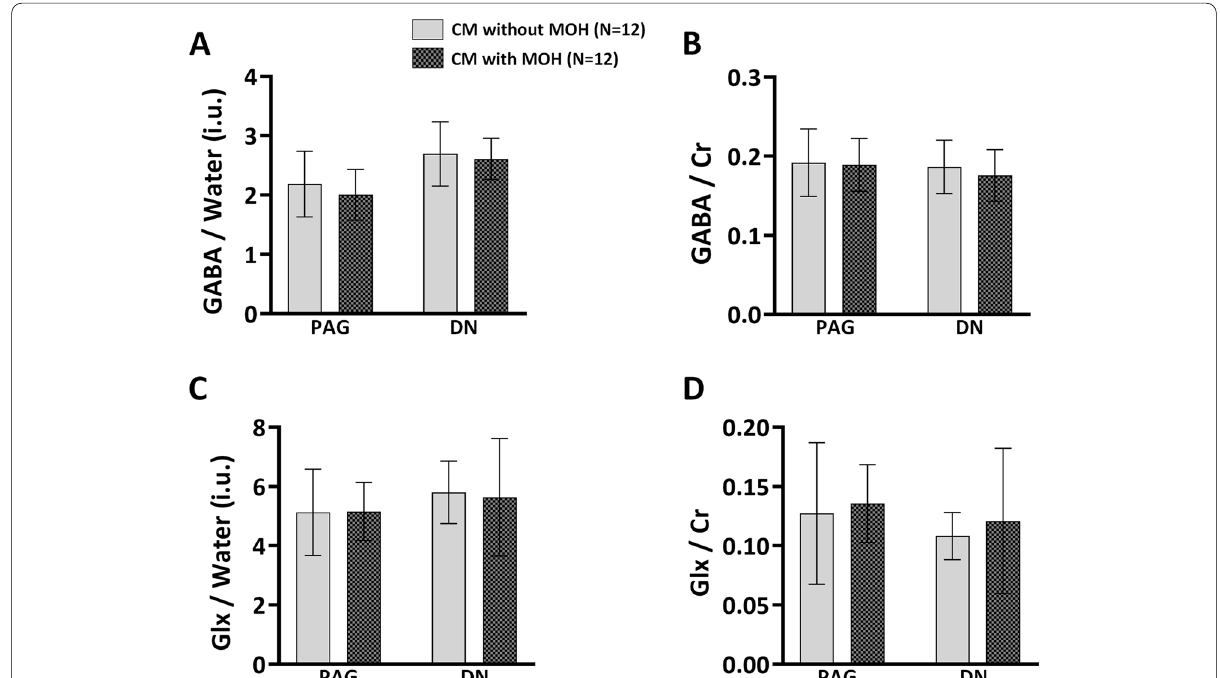
Fig. 4 Brain neurochemical levels of the CM with and without MOH groups. a GABA/water (international units [i.u.]) in the PAG and DN of the patients having CM with and without MOH. b GABA/Cr in the PAG and DN of the patients having CM with and without MOH. c Glx/water (i.u.) in the PAG and DN of the patients having CM with and without MOH. d Glx/Cr in the PAG and DN of the patients having CM with and without MOH. Abbreviations: CM, chronic migraine; MOH, medication overuse headache; PAG, periaqueductal gray; DN, dentate nucleus; Cr, creatine; GABA, gamma-aminobutyric acid; Glx,